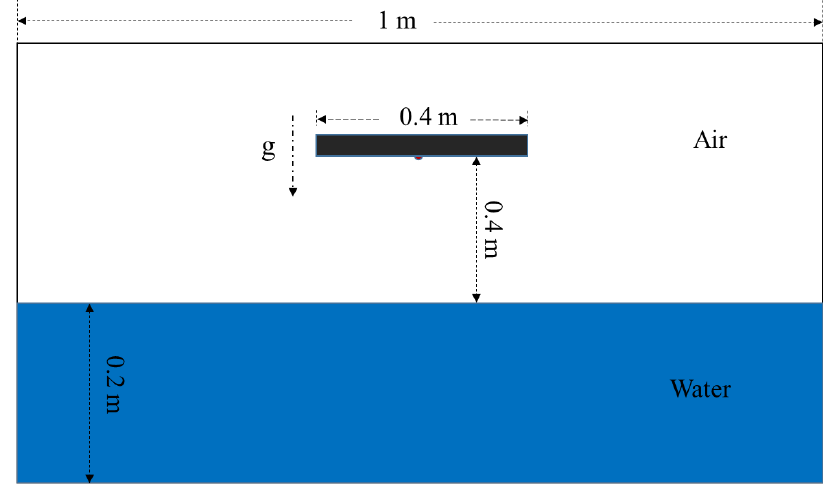
Figure 6. Initial set up of a flat plate impact on